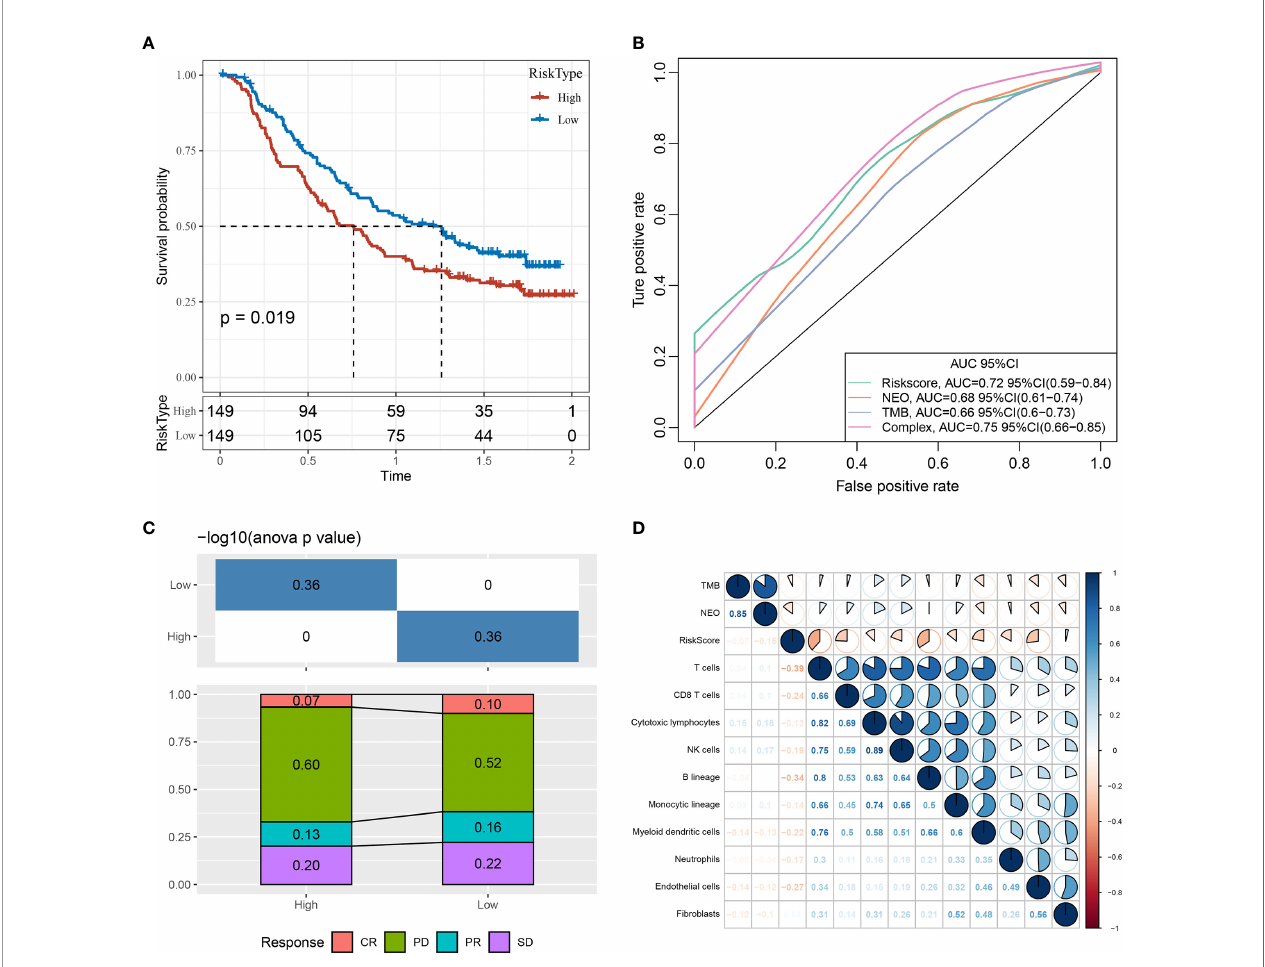
FIGURE 14 | Prediction ef fi cacy of the risk model based on the 10-gene signature. (A) Kaplan – Meier curves of high- and low-risk groups using the Imvigor210 dataset. (B) Evaluation of the risk model against standard prediction models of immunotherapy response using the Imvigor210 dataset. (C) Corresponding stacked plots of immunotherapy response among high- and low-risk groups in the Imvigor210 dataset. (D) Correlation between RiskScore, immune score, TMB, and NEO using the Imvigor210 dataset. CR, complete response; PR, partial response; SD, stable disease; PD, progressive